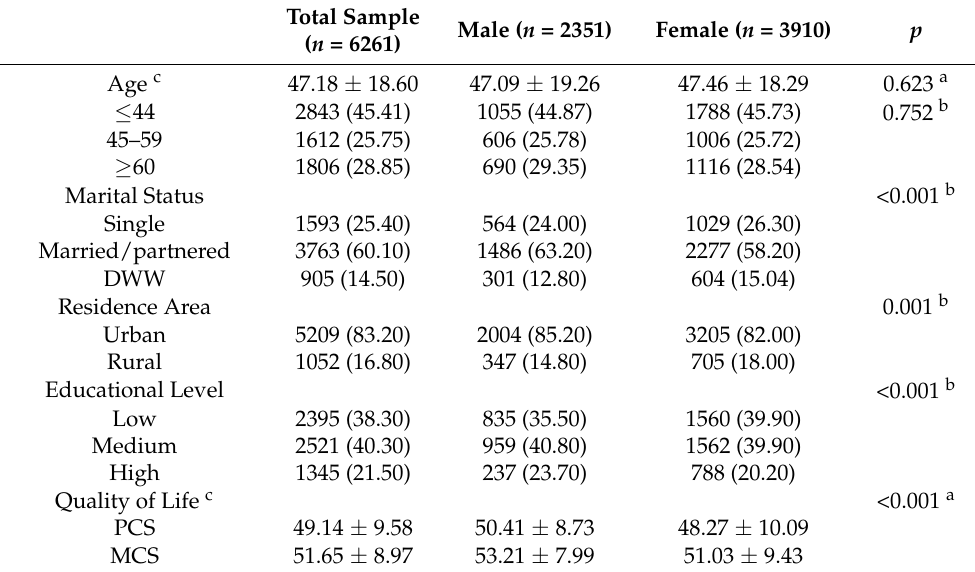
Table 1. Sociodemographic characteristics and quality of life by gender ( n = 6261).